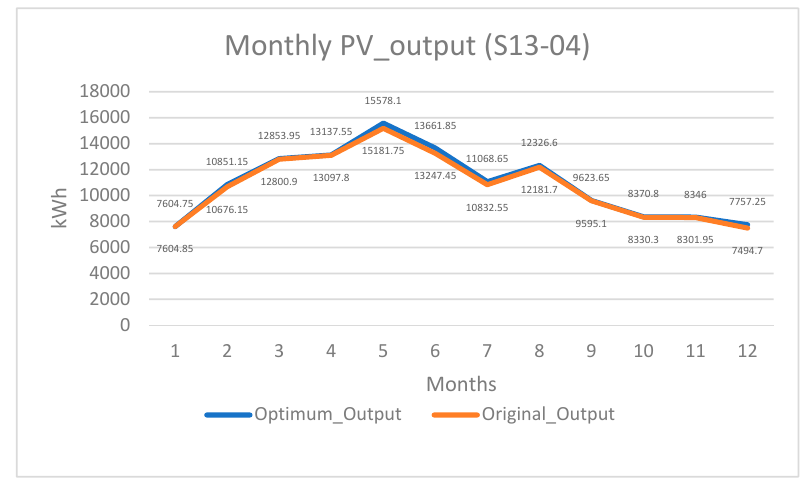
12 of 13 Figure A3. Monthly tilt angles and outputs of S13-03 module.